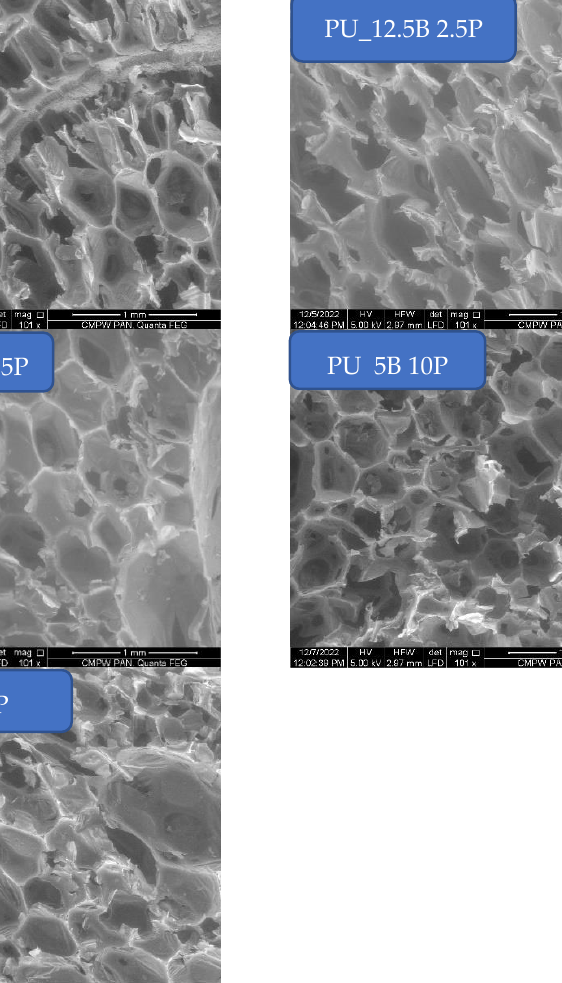
Table 2. Effect of buckwheat hulls and perlite on the structural parameters of rigid PU foams. Sample